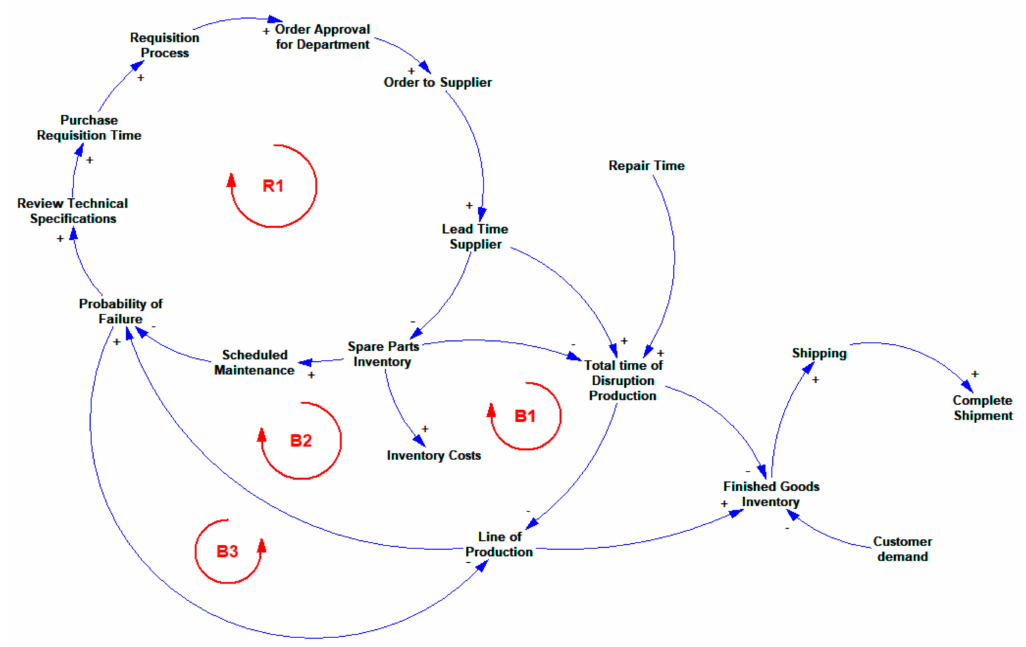
Figure 2. Causal loop diagram of the system for supplying special